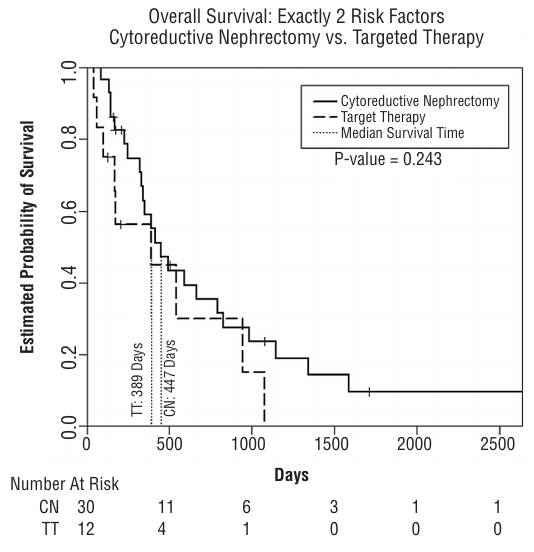
figure 2 - kaplan-Meier estimated survival comparing patients in cytoreductive nephrectomy group (cn) to targeted therapy group (TT) for patients with exactly two risk factors.